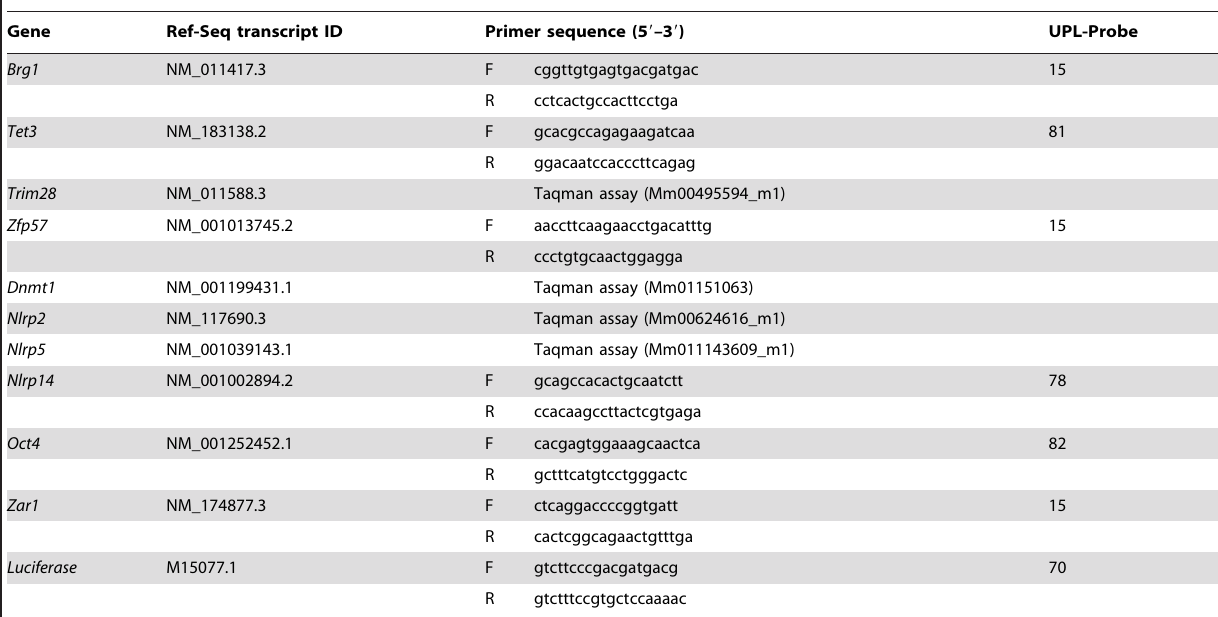
Table 1. qRT-PCR primer sequences.